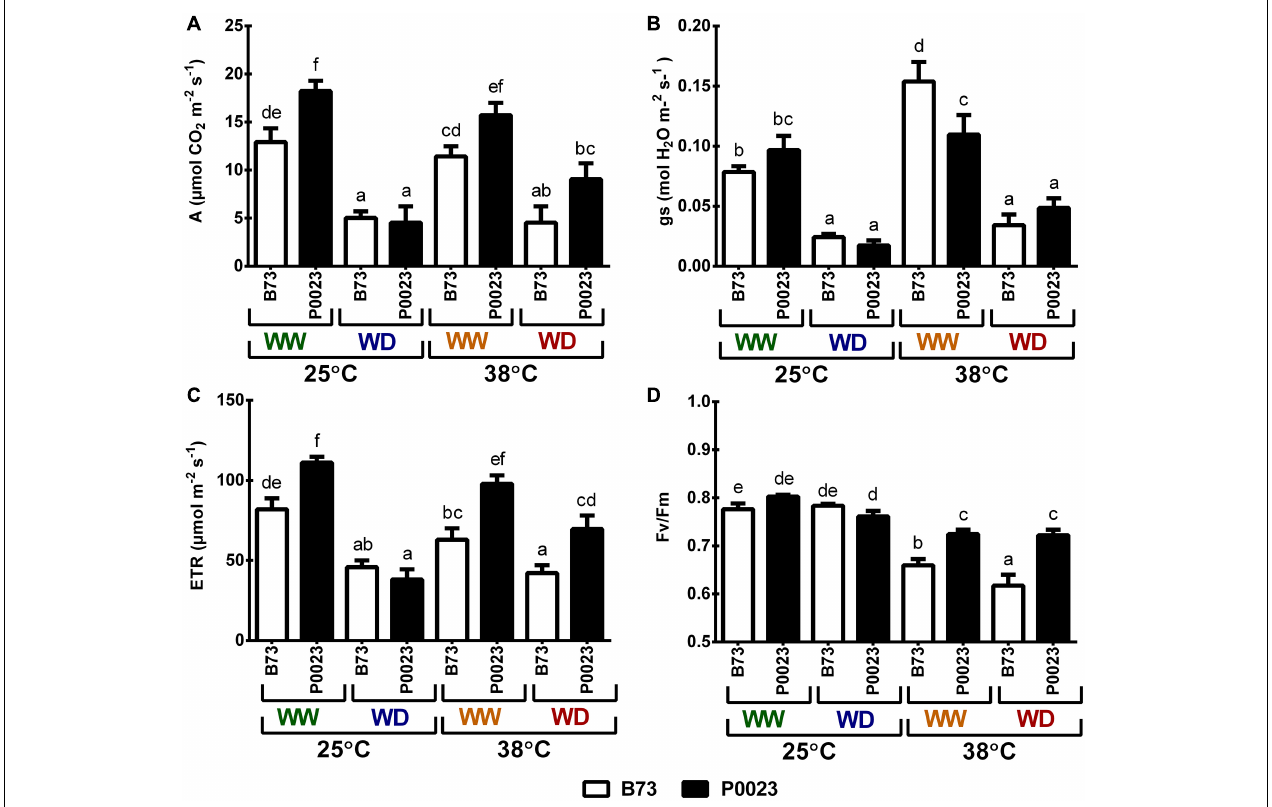
FIGURE 1 | Steady-state photosynthesis in two maize genotypes (B73, P0023) grown under WW and WD conditions and acclimatized to 25 or 38 ◦ C. (A) Net CO 2 assimilation, (B) stomatal conductance, (C) ETR and (D) maximum quantum yield of primary PSII photochemistry (Fv/Fm) were measured at 600 µ mol m − 2 s − 1 and 400 µ mol CO 2 mol − 1 in fully expanded leaves from 4-week-old maize plants. Values are means ± SEM ( n = 5 biological replicates). Different letters denote statistically significant differences between treatments (Duncan analysis, p <